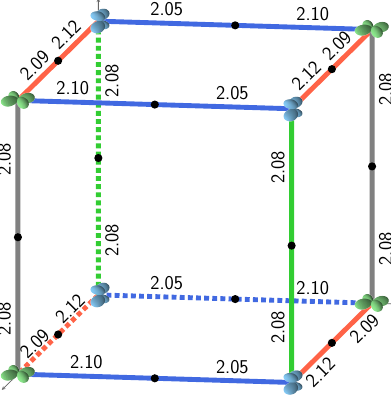
Figure A3. The configuration indicated as columnar by Varignon et al., see Table III of Reference [14] of the main